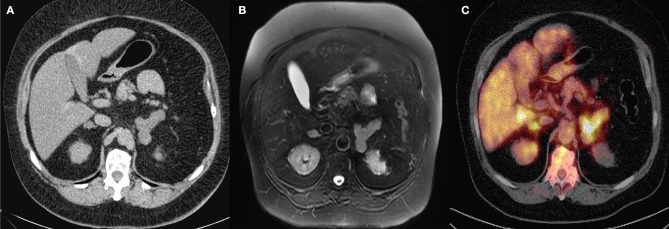
(A) Pre-contrast abdominal computed tomography (CT) scan (case # 3). (B) Post-contrast abdominal CT (C) Fluorine-18-fluorodeoxyglucose positron emission tomography 18F-FDG-PET/CT (case # 3) with Cushing's syndrome ACTH pituitary independent with bilateral adrenal nodules.